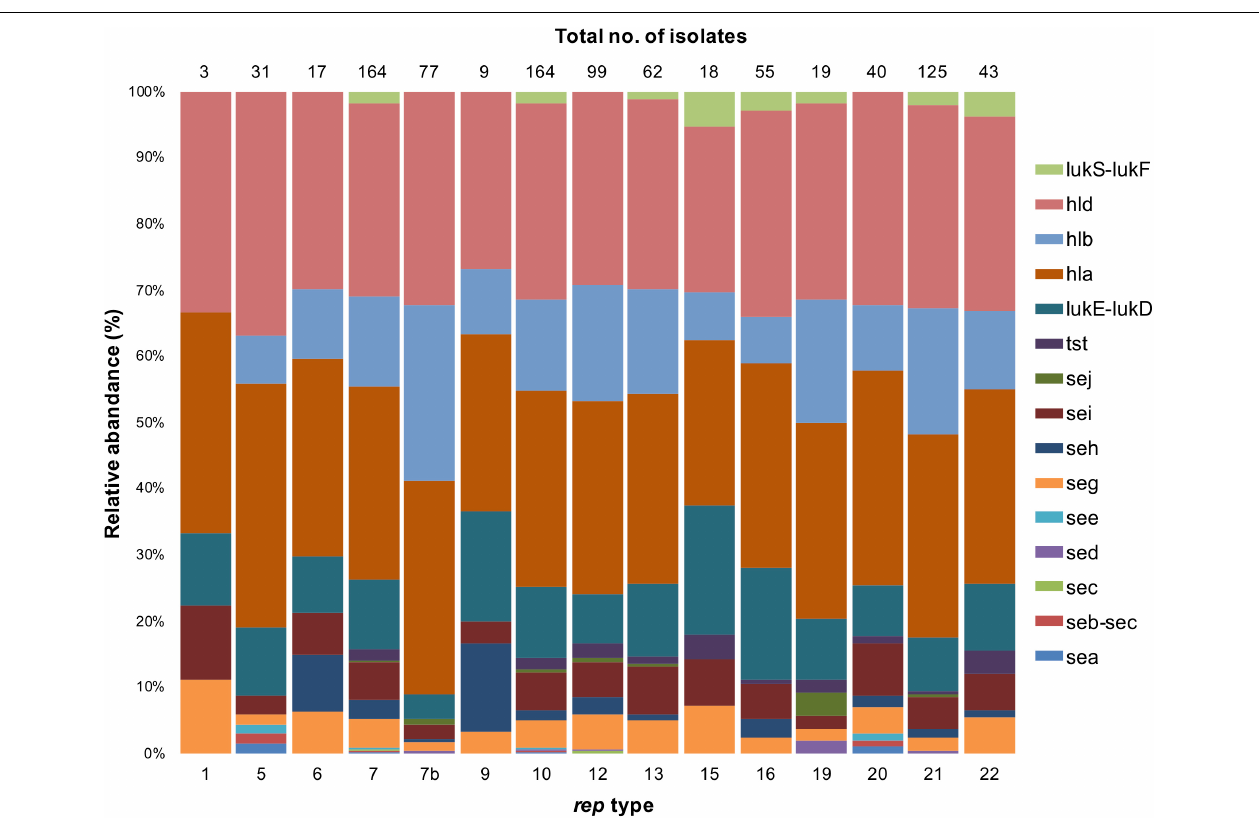
FIGURE 7 | Stacked column bar graph showing the relative abundance of virulent S. aureus isolates according to the rep type. Isolates are denoted by different colors according to toxin genes as